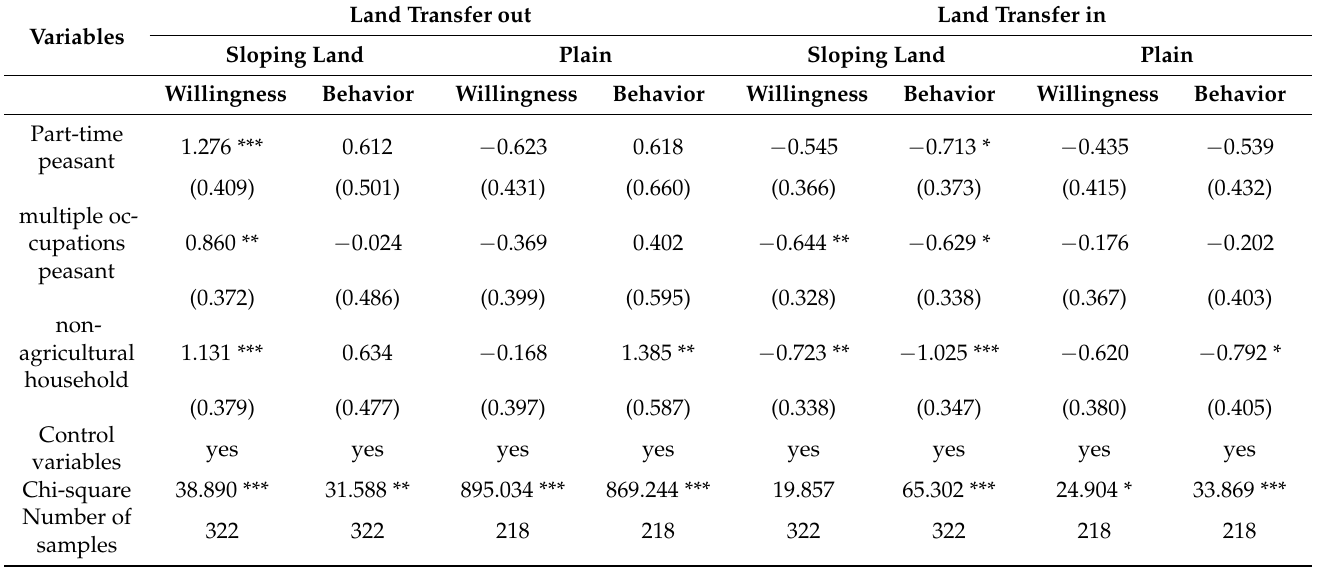
Table 9. Regression results of willingness and behavior of land transfer for different arable land